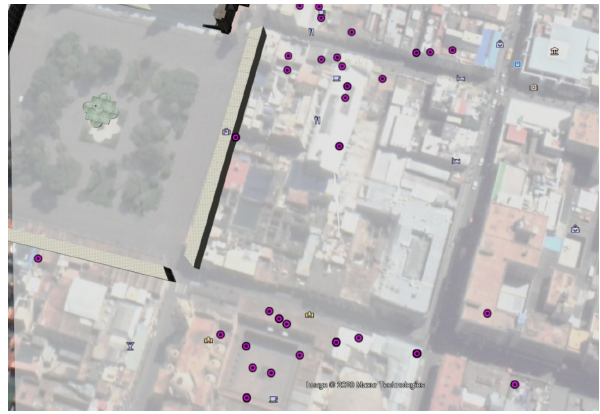
Figure 4. Detailed example from the second cleaning